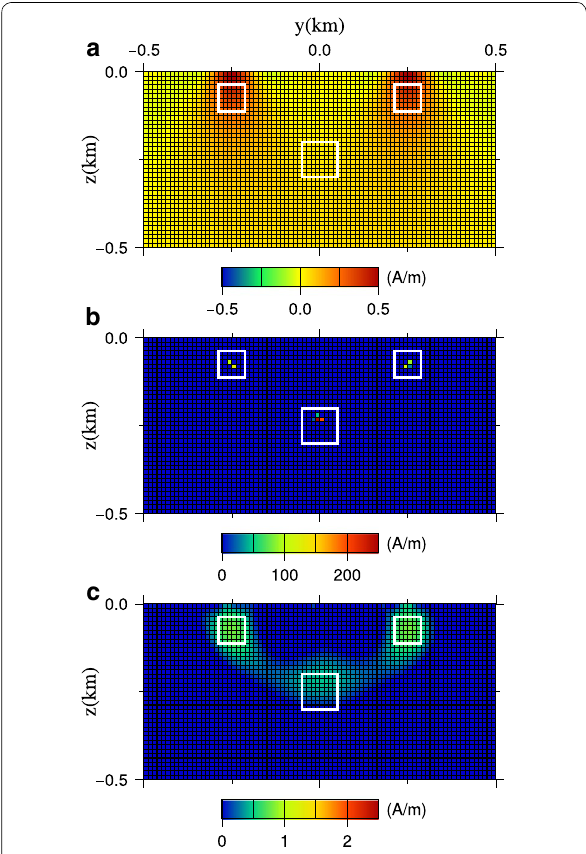
Fig. 6 Optimal models derived by L1–L2 norm combined regularization. Optimal models derived by L1–L2 norm combined regularization using weighting function w S 1 with a α α 1.0 . and c α 0.8 . White squares indicate the location of the = = magnetized blocks of the true